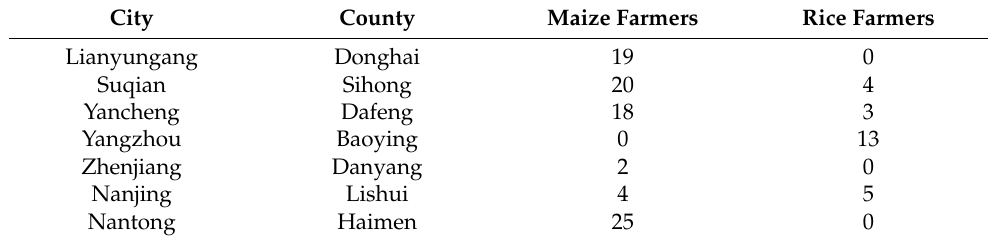
Table 7. The distribution of maize and rice farmers. City